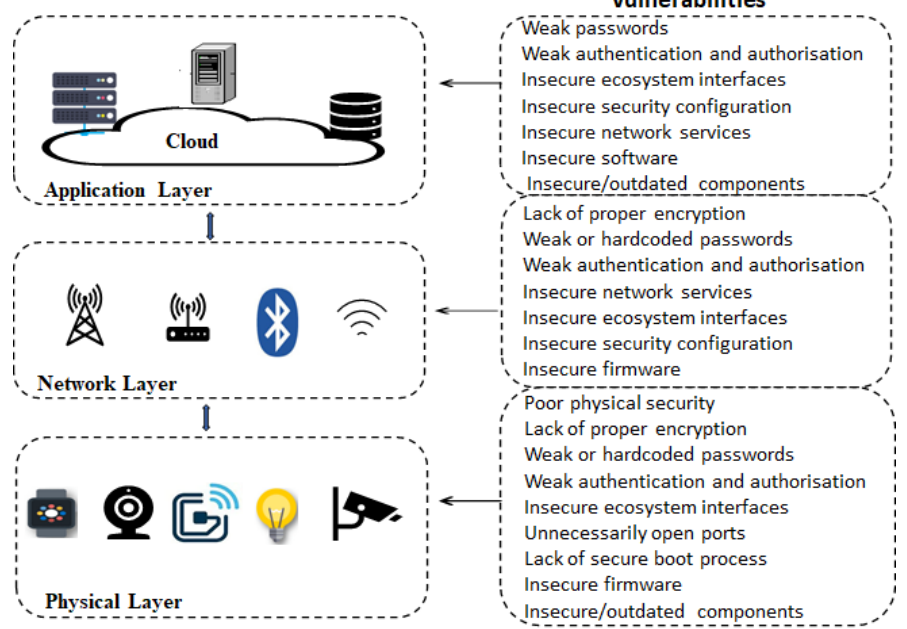
Figure 1. Layered IoT architecture with associated IoT vulnerabilities in different layers.